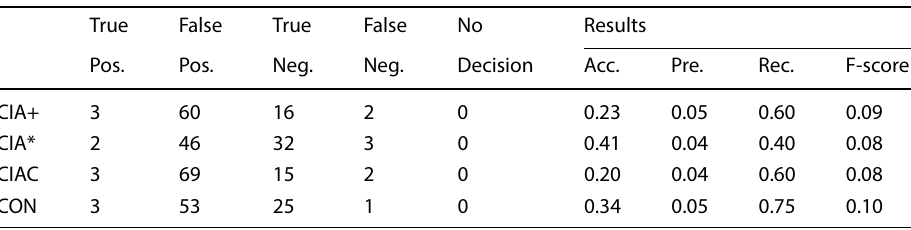
Table 7 Binary classifications and results: denial-of-service data